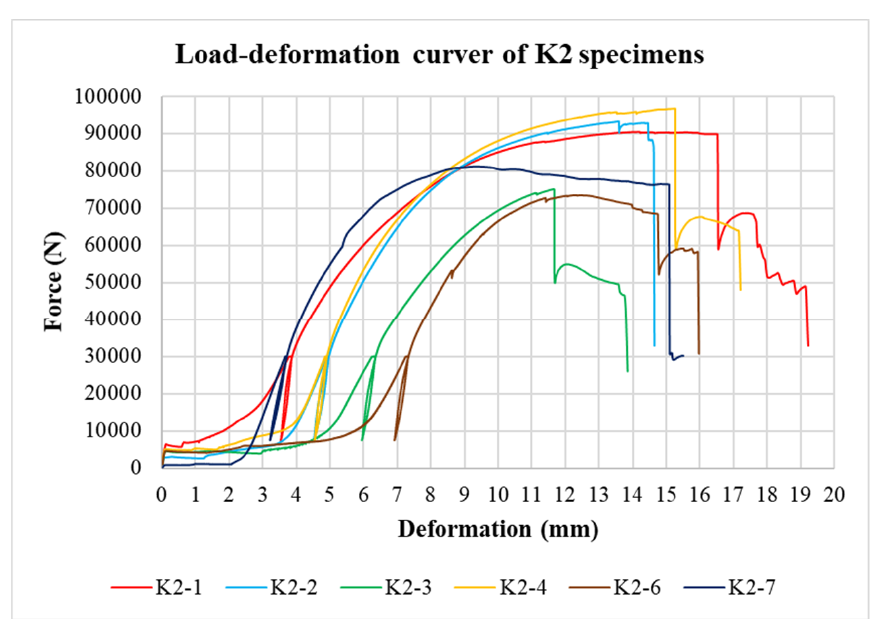
Figure 8. Load-deformation curves of K1 specimens.